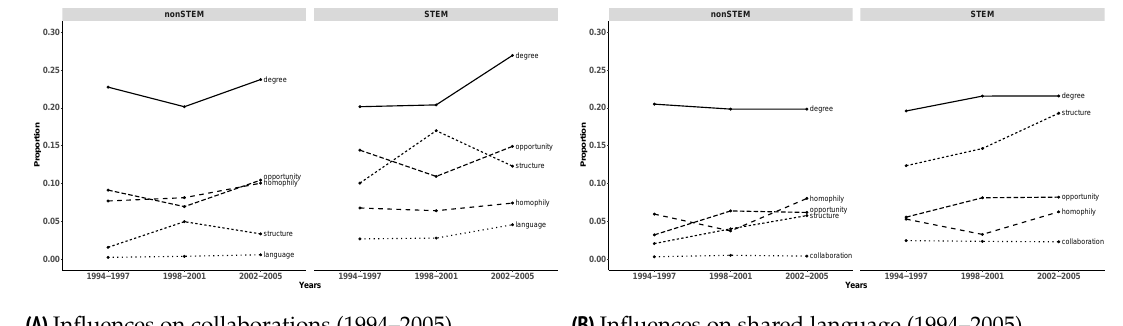
Figure 2: Relative importance of effects contributing to collaborations ( A ) and shared language ( B ) among non-STEM (first column) and STEM (second column) faculty members (averages and variation shown across time). Shared language = existing tie X in shared language network → new tie Y effect in collaboration network. Collaboration = existing tie X in collaboration network → new tie Y effect in language network. Homophily = same attributes (same gender, same race, and similar age). Opportunity = same environment (same scientific field and same department). Structure = transitive triads effect (clustering), degree of alter effect (centralization), and degree assortativity effect (stratification). Degree = degree effect